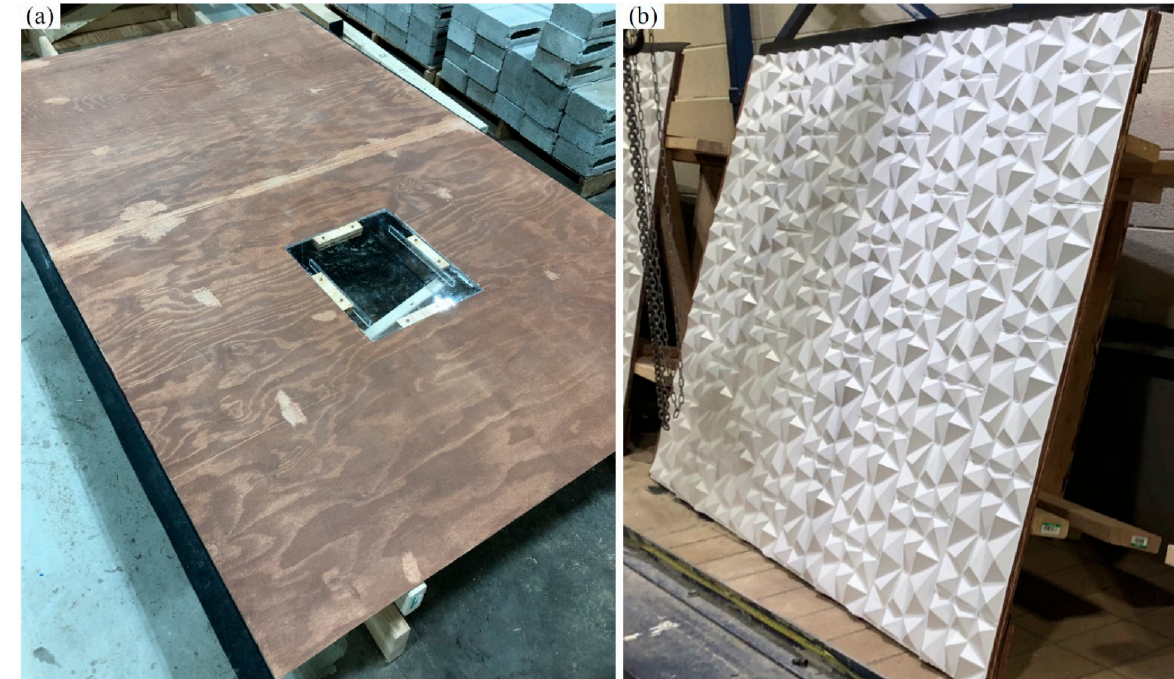
Figure 3. Bottom surface of the ice cover: ( a ) smooth condition, and ( b ) rough condition.